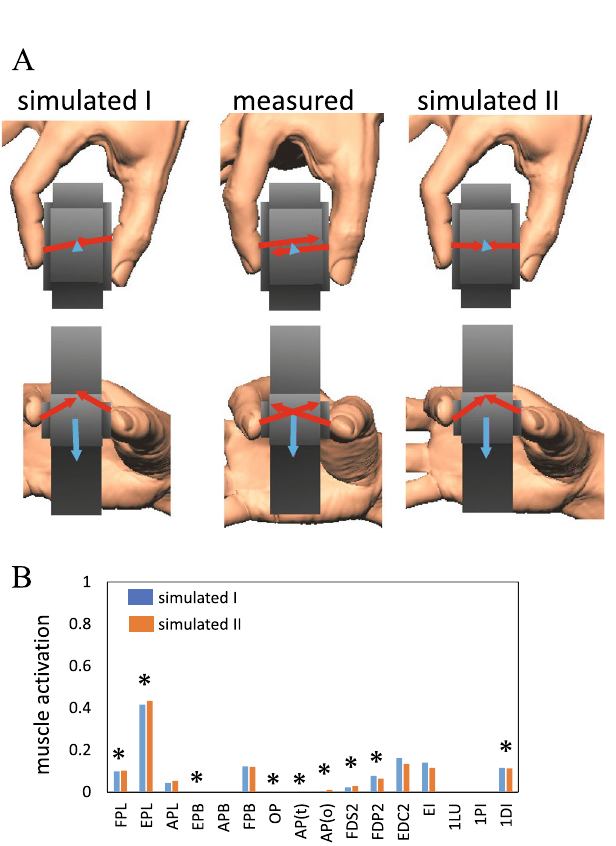
Figure 7. Comparisons of the measured fingertip forces of the free pinch with those estimated based on the present method from the two sets of initial values (I and II) ( A ). The estimated muscle activations are also presented ( B ). Asterisks indicated muscles that are reportedly active during precision grip 25–27